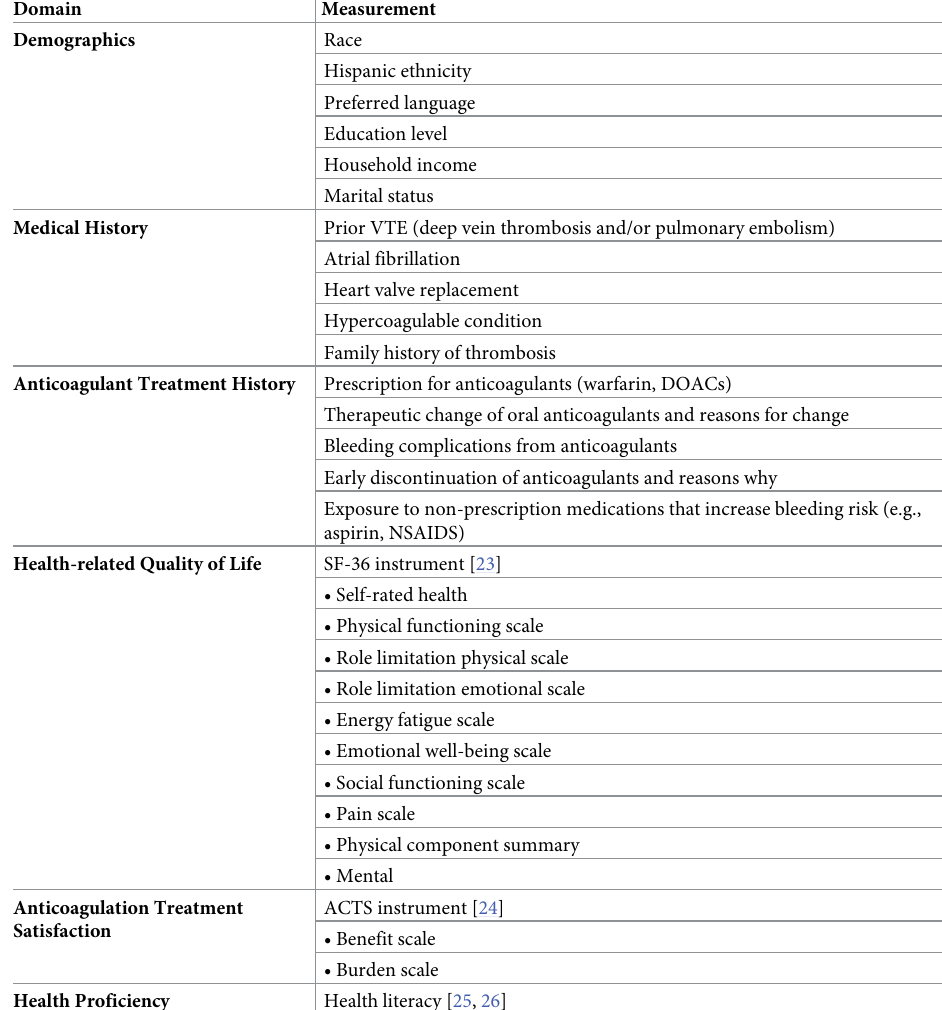
Table 1. Survey domains and measurements obtained in the ALTERNATIVE survey